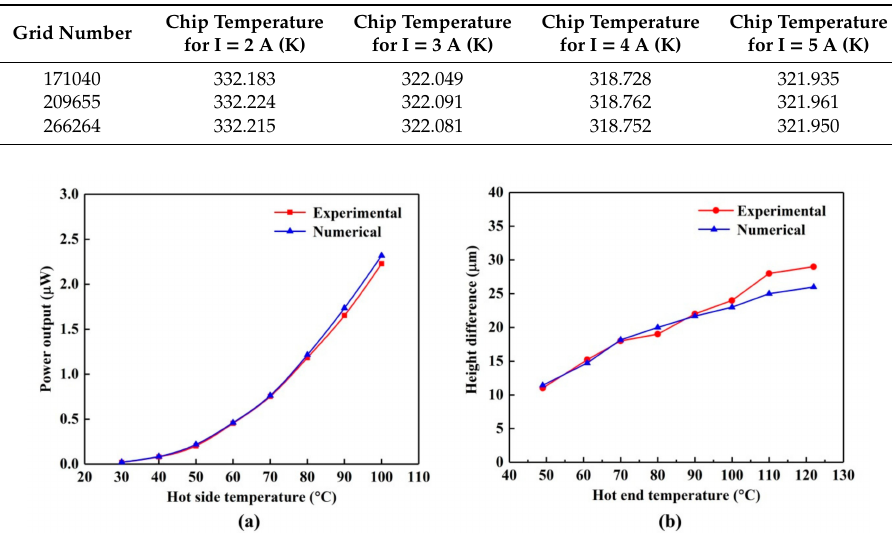
Table 3. Chip temperature under three grid systems.